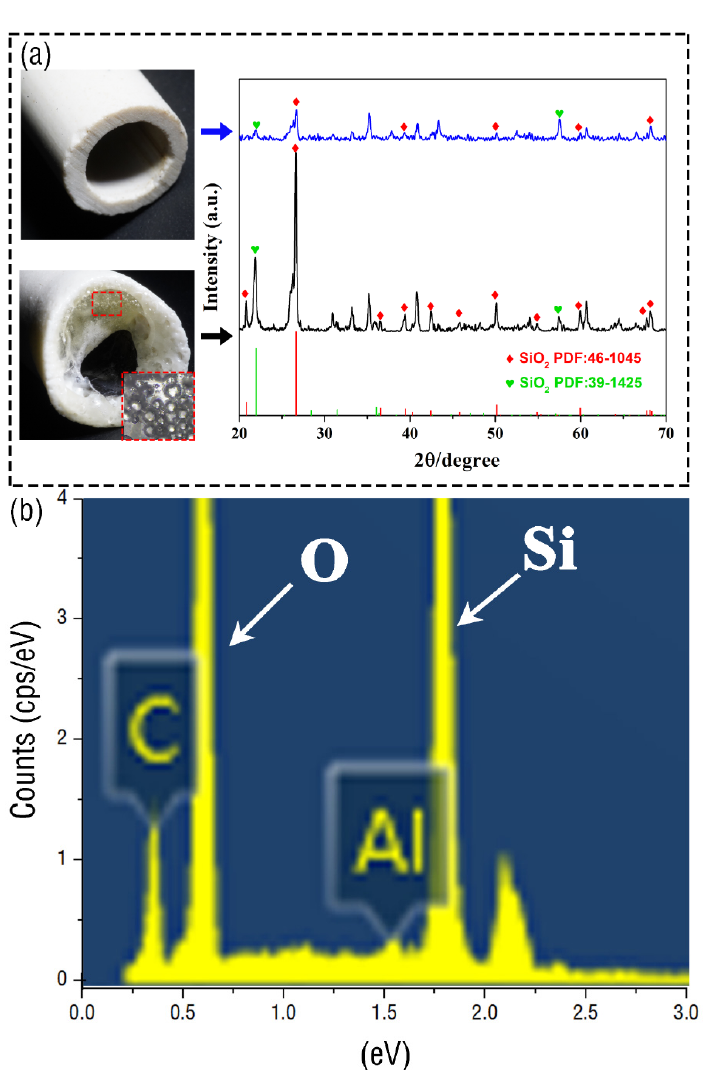
Figure 5. ( a ) Image comparison and XRD of the ceramic tube before and after discharge. ( b ) Analysis